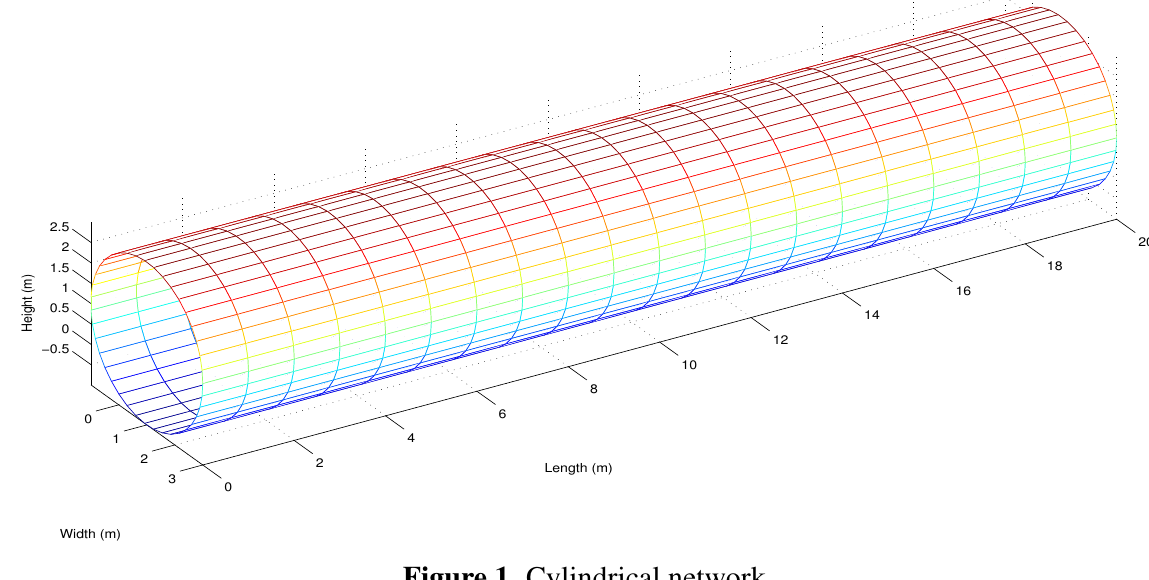
Figure 1. Cylindrical